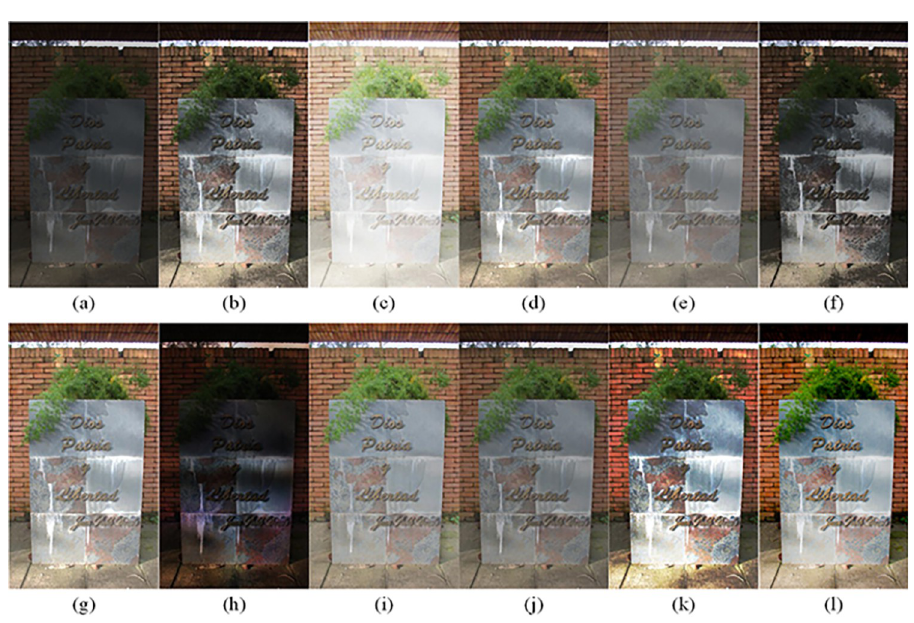
Fig 29. Comparisons of the ten algorithms in enhancing low-light image 19. (a) low-light image (b) AGCWD (c) Al-Ameen (d) BHE2PL (e) BIMEF (f) BPDHE (g) LIME (h) MSRCR (i) NPEA (j) SRIE (k) OURS (l) Normal light image.